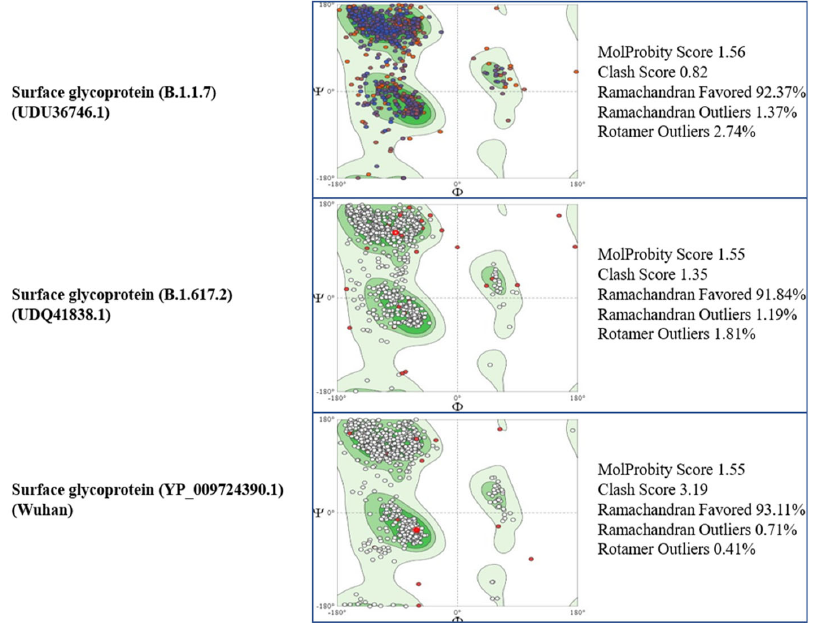
Figure 3. Comparison of the Ramachandran plots and the MolProbity results of the surface glycoproteins.